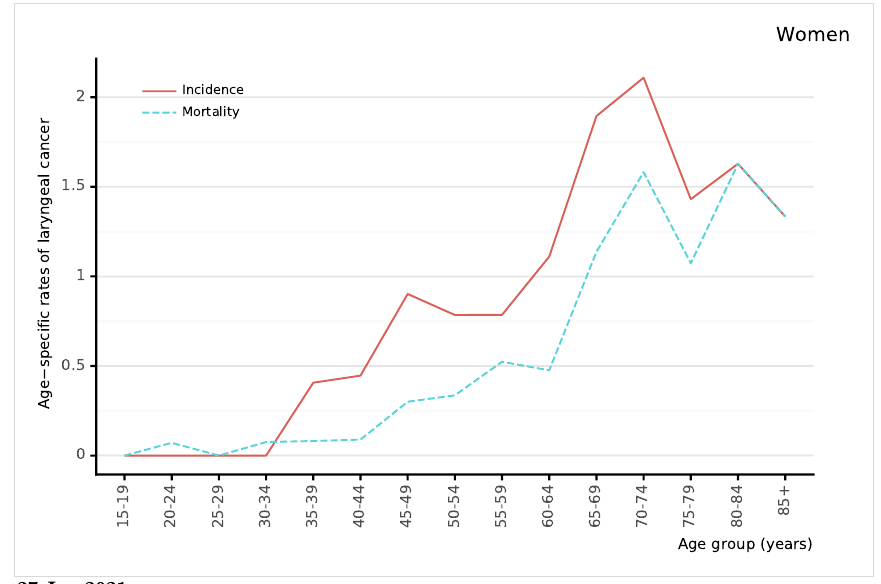
Figure 53: Comparison of age-specific laryngeal cancer incidence and mortality rates among women in Peru (estimates for